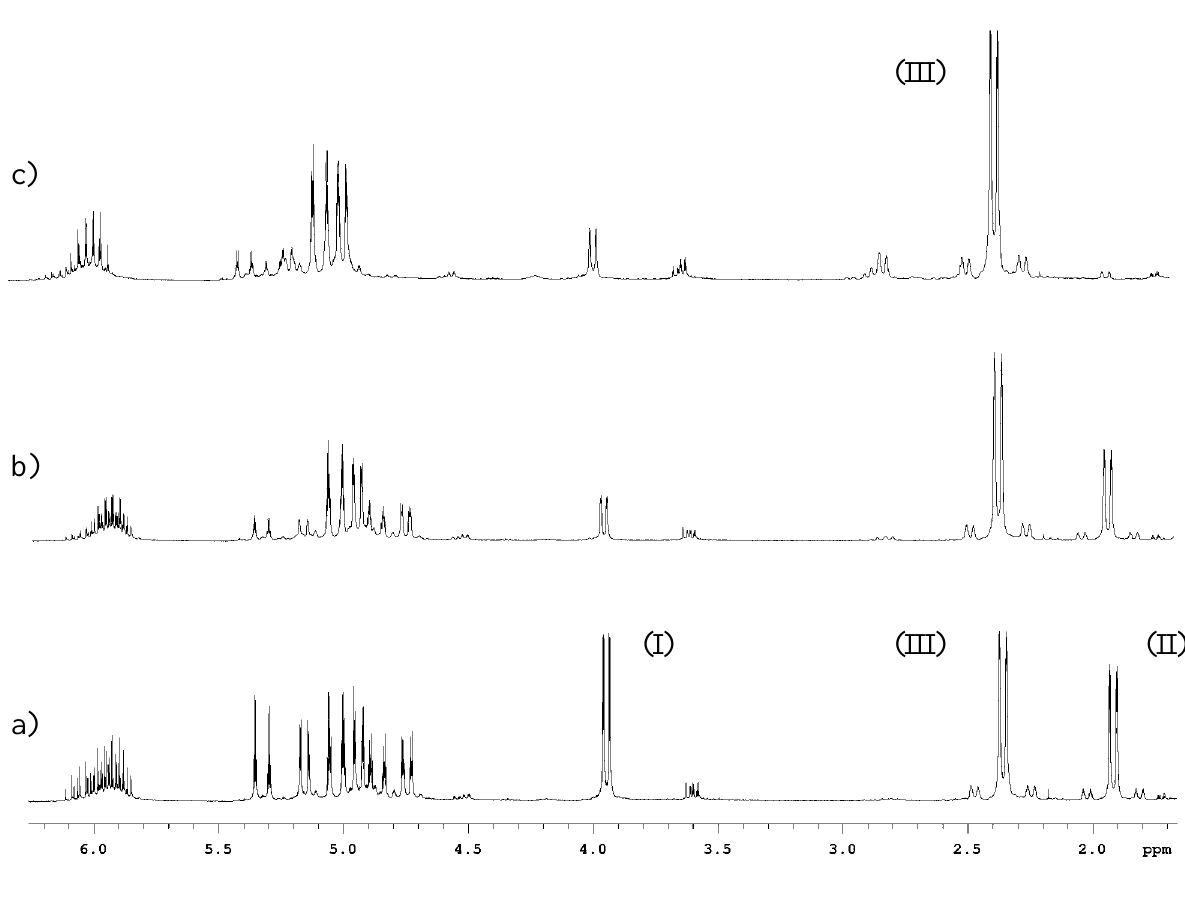
Figure 4. Partial 1 H-NMR spectra in CDCl solution. a) 5 minutes; b) 15 minutes; c) 30 minutes. Assignments: tin in HNO 3